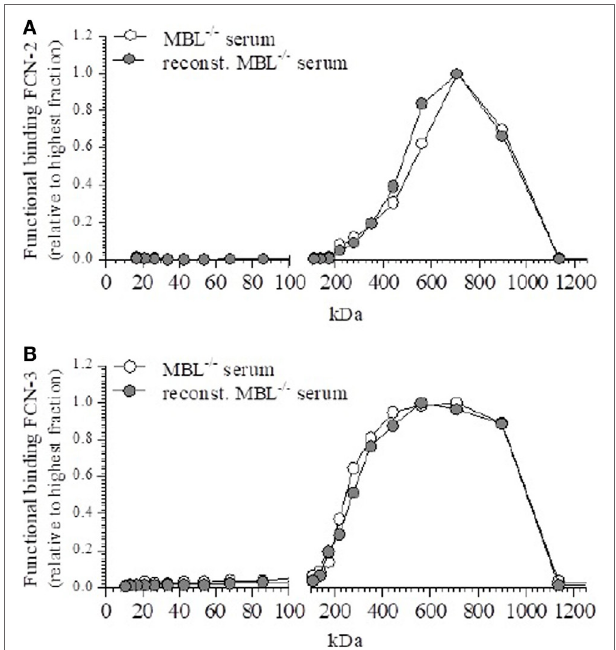
FigUre 4 | Functional binding of ficolin (FCN)-2 and FCN-3. Effect on the distribution of FCN-2 and FCN-3 after reconstitution to 50 µg/ml mannan- binding lectin (MBL). (a) Fractions were tested for the ligand binding of FCN-2 before and after reconstitution. (B) Fractions were tested for the ligand binding of FCN-3 before and after